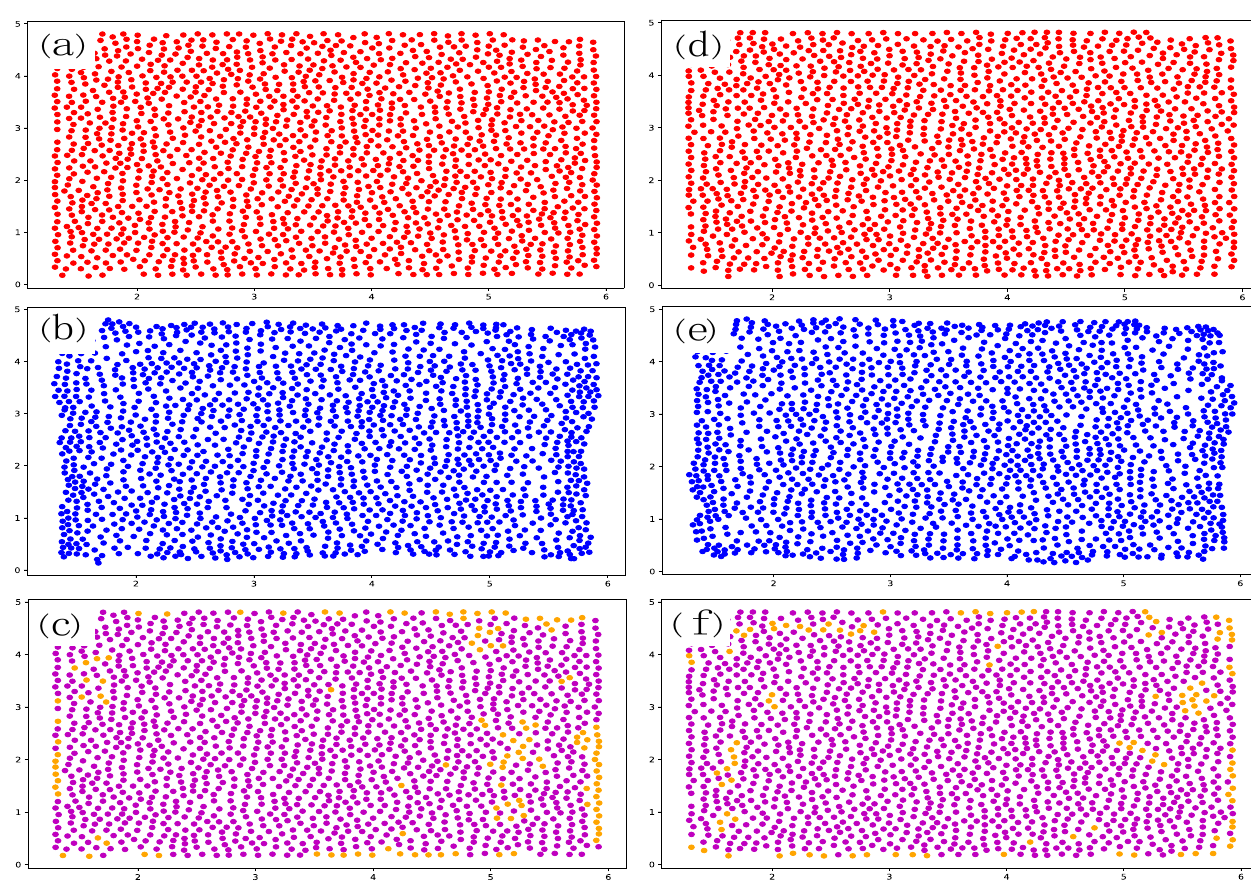
Figure 8. The prediction results for granular systems with different configurations of the disorder degree of 1:1. The red particle map is the original coordinate map of the granular system, the blue particle map is the prediction map, the magenta particles are the effective prediction particles, and the orange particles are the ineffective prediction particles. Moreover, ( a – c ) show a granular system of conf2 where the RMSE is 0.0375 and the EPA is 91.79%; ( d – f ) show a granular system of conf4 where the RMSE is 0.0350 and the EPA is